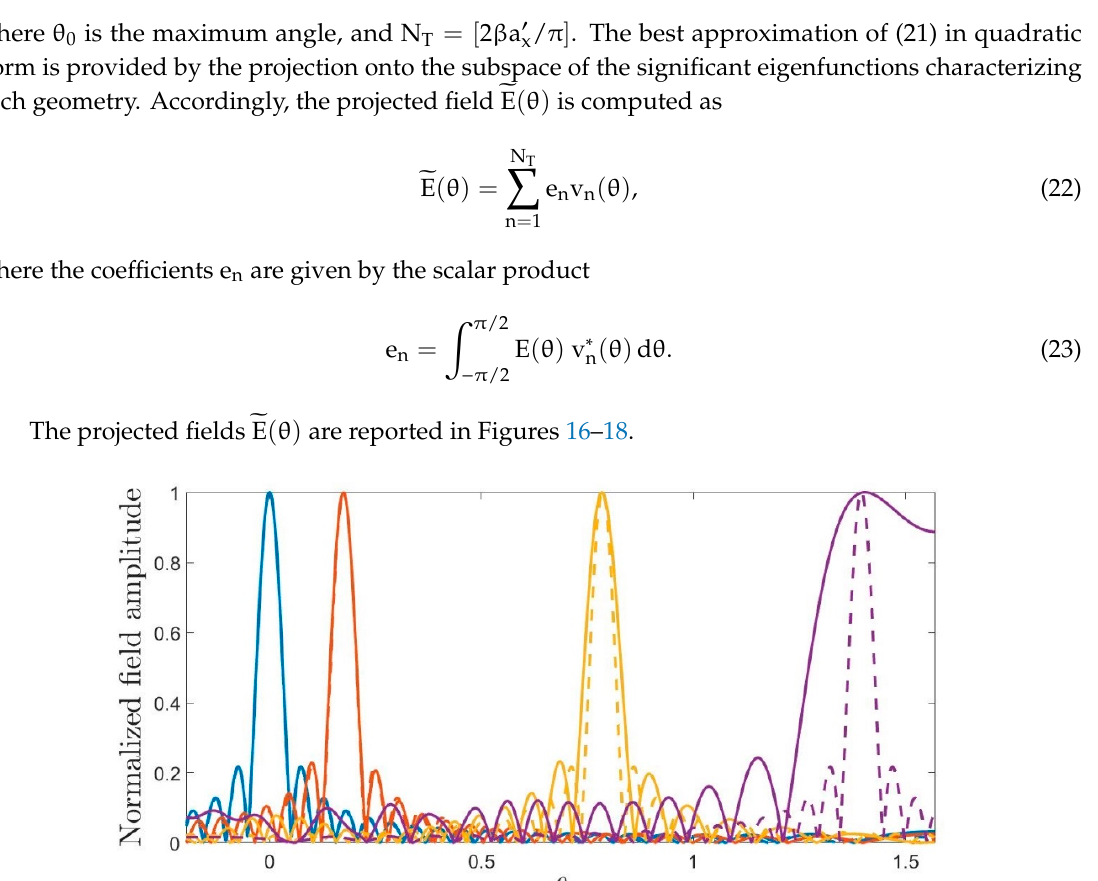
Figure 16. Normalized field amplitude of the desired field E(θ) (dashed curves) and the projected field E(cid:3561)(θ) (solid curves) for the linear source, varying the main beam angle θ (cid:2868) = 0, 0.17,0.78, 1.4 . The panels only zoom into a portion of the observation domain.